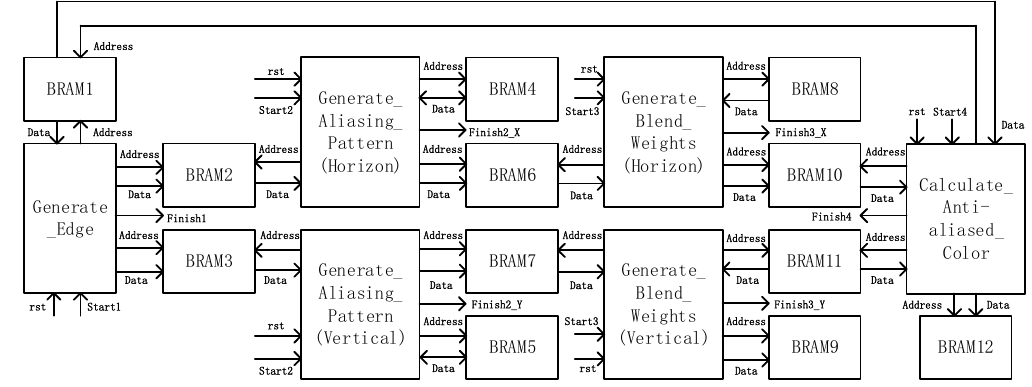
Figure 8. Diagram of the whole system implemented in FPGA.